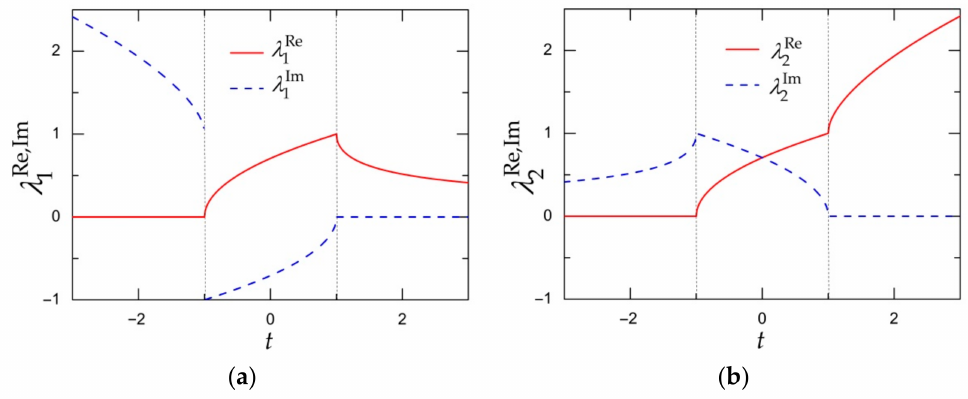
Figure 1. The real and imaginary parts of eigenvalues λ 1 ( a ) and λ 2 ( b ) in formulae (15) versus √ t = a 1 / a 2 under constraints